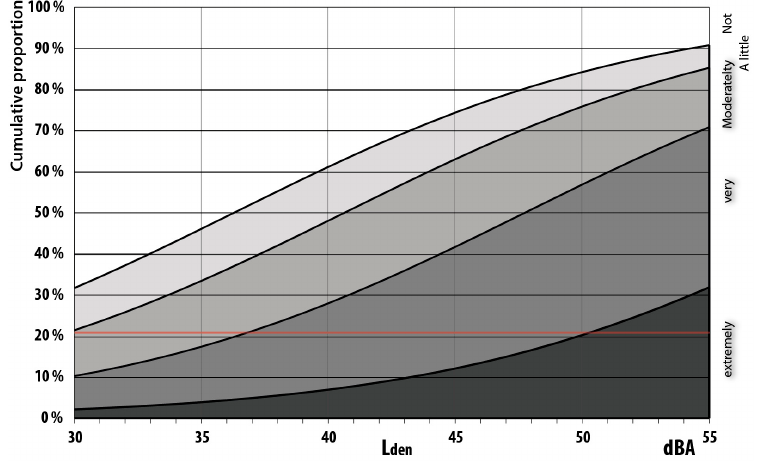
Figure 8. Exposure–effect relationships for annoyance right outside the dwelling from wind turbine noise as a function of evening and night weighted equivalent noise levels (Lden). n = 87.